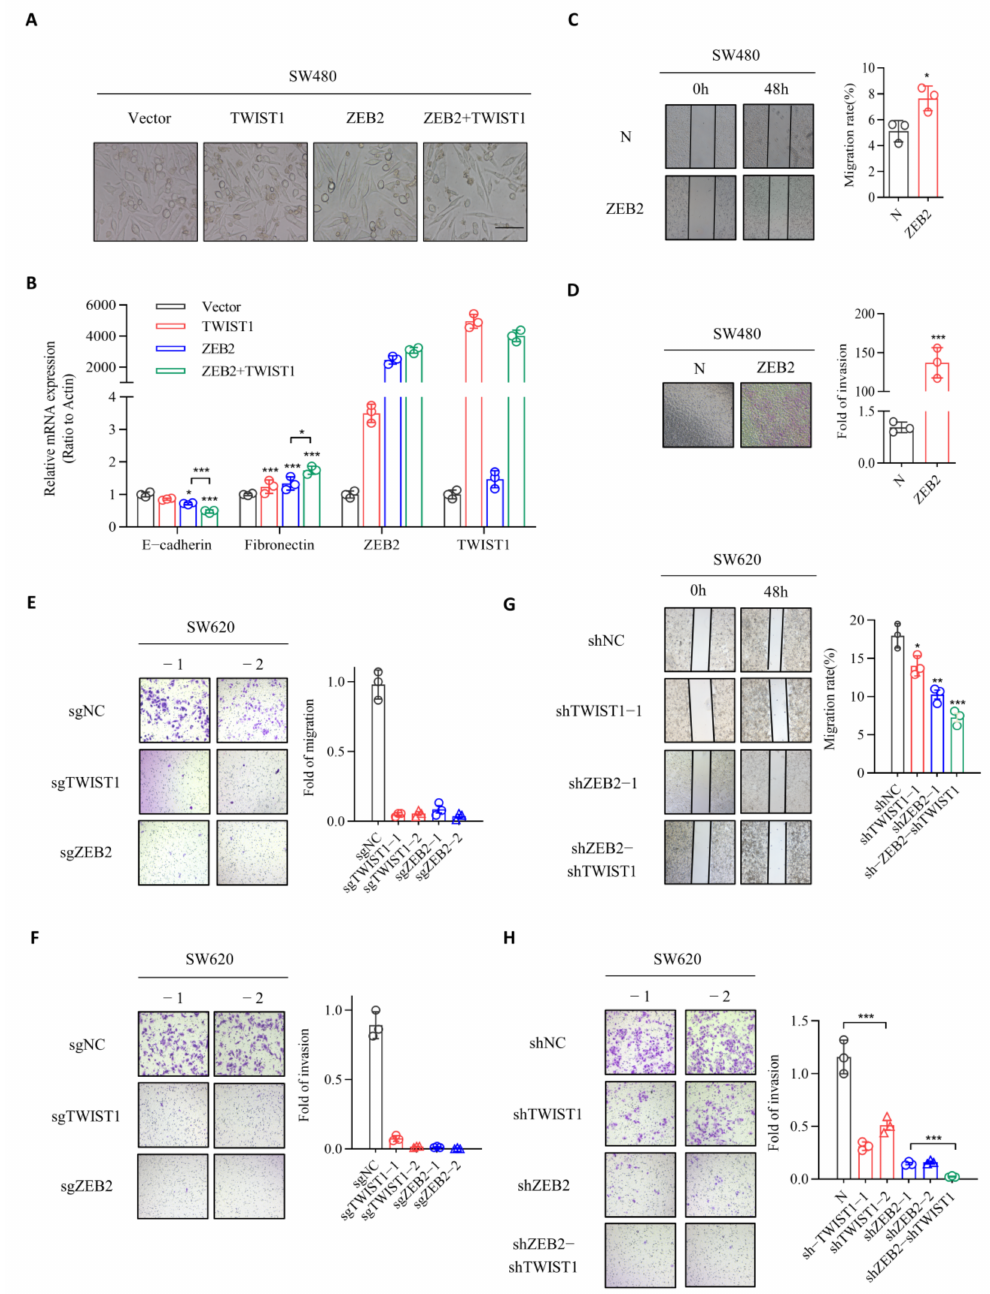
Figure 2. ZEB2 and TWIST1 both contribute to EMT, migration, and invasion processes of CRC. ( A ) The images of cell morphology about SW480+vector, SW480+TWIST1, SW480+ZEB2, and SW480+ZEB2+TWIST1 were captured by phase-contrast microscopy at × 20 magnification. Scale bars, 20 µ m. ( B ) qRT-PCR analysis for mRNA expression levels of the EMT related genes E-cadherin, Fibronectin, ZEB2, TWIST1. ( C , D ) The migration and invasion abilities of SW480 cells (overexpress- ing ZEB2 or control) were analyzed by wound healing assays and transwell invasion assays. Data in the histogram are shown as the mean ± SD from three independent experiments. ( E – H ) The migration and invasion abilities of SW620 cells (SW620-sgNC, SW620-sgTWIST1, SW620-sgZEB2; SW620-shNC, SW620-shTWIST1, SW620-shZEB2, and SW620-shZEB2-shTWIST1) were analyzed by transwell migration experiment, wound healing assays, and transwell invasion assays. Data in the histogram are shown as the mean ± SD from three independent experiments. * p ≤ 0.05; ** p ≤ 0.01; *** p ≤